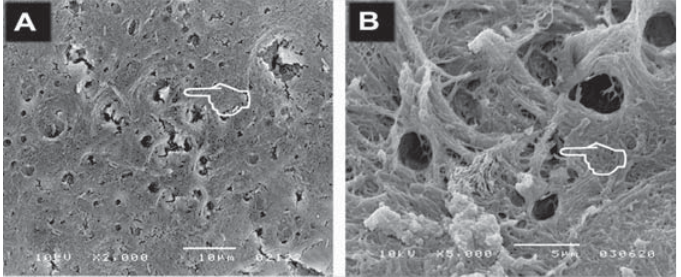
Figure 5- Scanning electron microscopy (A and B) of the morphology of root surfaces treated with simultaneous manual